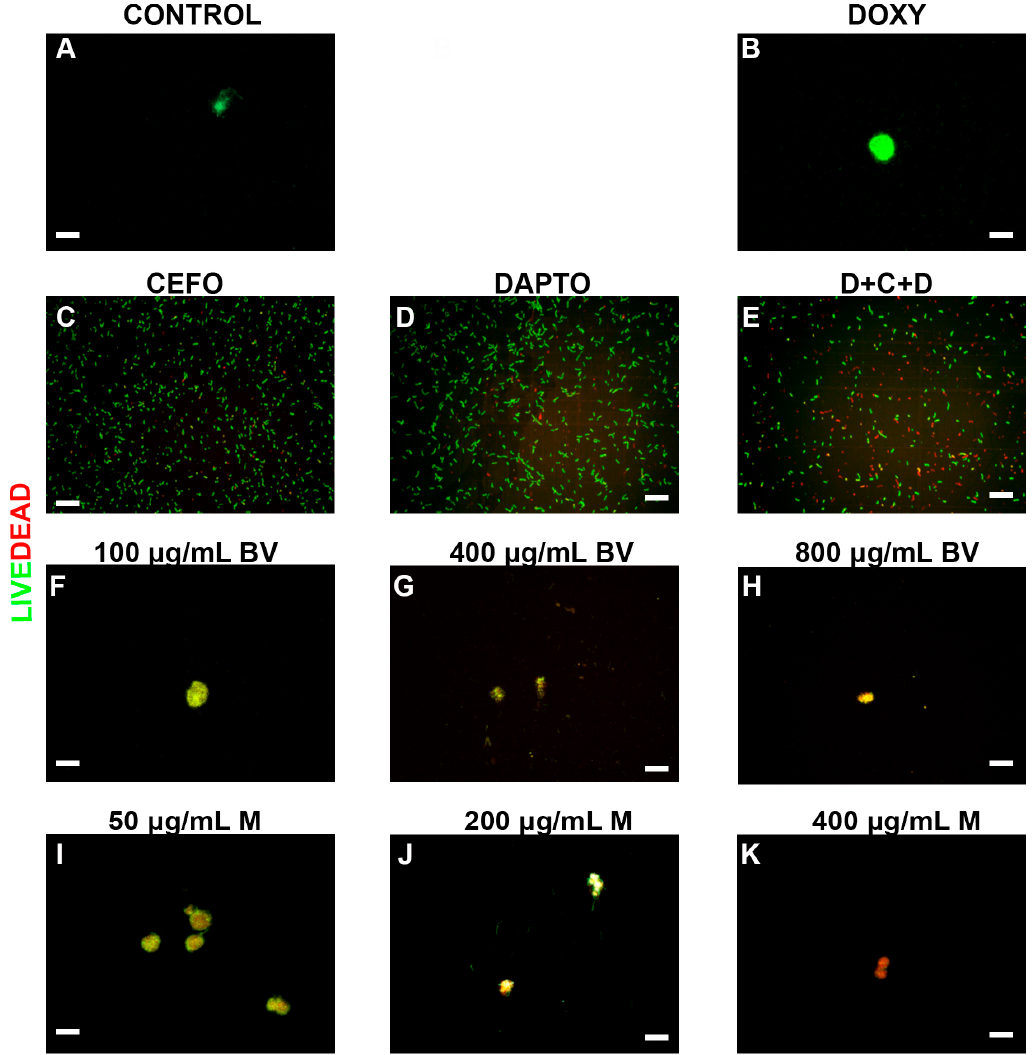
Figure 3. Representative Live/Dead staining images of B. burgdorferi stationary phase persister cultures following treatment with different antimicrobial agents. Cells were stained with SYBR Green I/PI as outlined in the Methods and representative images were taken at 100 × magnification. Panel ( A ) Borrelia culture treated only with PBS was used as a negative control. Panel ( B ) Doxycycline (DOXY) treated, Panel ( C ) Cefoperazone (CEFO) treated, Panel ( D ) Daptomycin (DAPTO) treated and Panel ( E ) Three-antibiotic combination (D + C + D). Panels ( F – H ) Bee venom (BV) was used in increasing concentrations while Panels ( I – K ) depicts melittin (M) treated cells. Live cells are stained with green color while dead cells are stained red. Scale bar: 100 μ m.